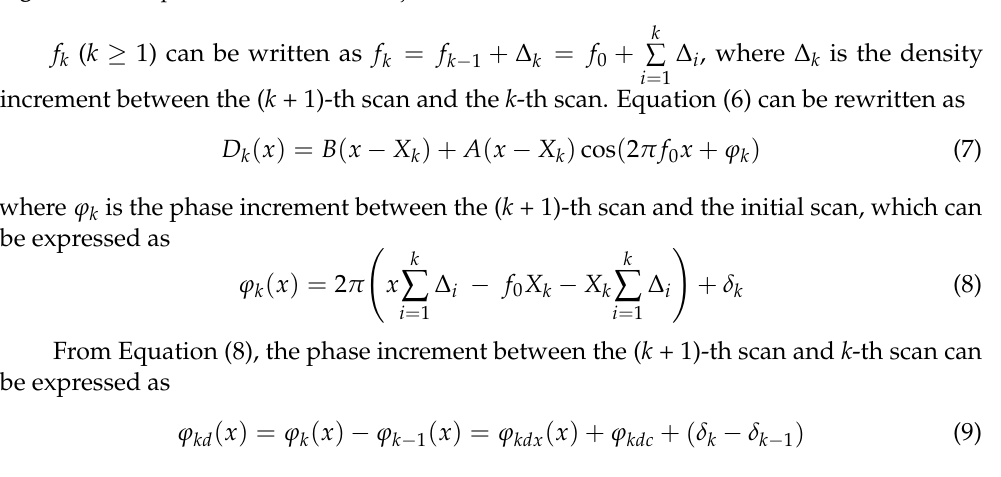
Figure 1. The exposure doses in three adjacent scans.